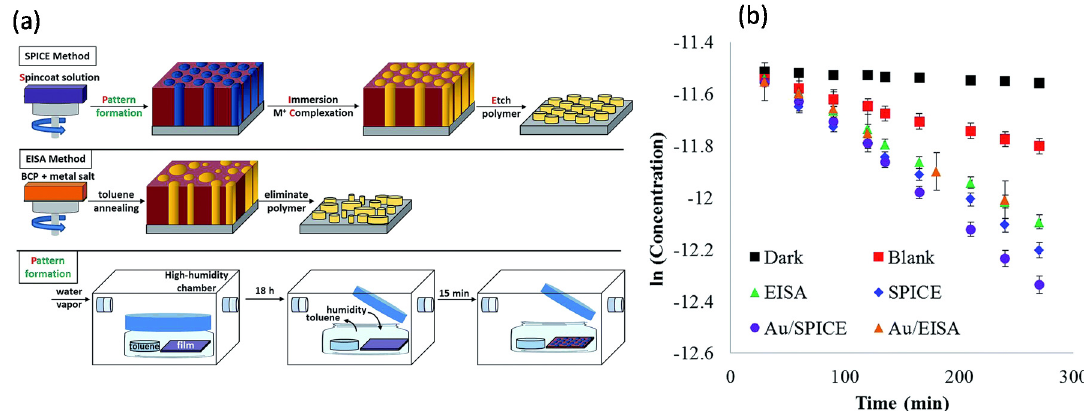
Figure 9. ( a ) The SPICE templating method decouples polymer annealing from the metal precursor gel incorporation. Traditional methods, represented by EISA, spin-coat an all-in-one solution that includes both polymer and metal precursor. Although EISA has fewer steps, it can produce irregular arrays or inorganic material. Pattern formation was achieved by annealing with toluene and water vapor, using standard solvent annealing techniques enclosed in a humidified glove box. ( b ) Plot of the natural log of MB concentration against irradiation time. Error bars represent standard deviations of the mean across three reproducibility studies. Adapted from [30].